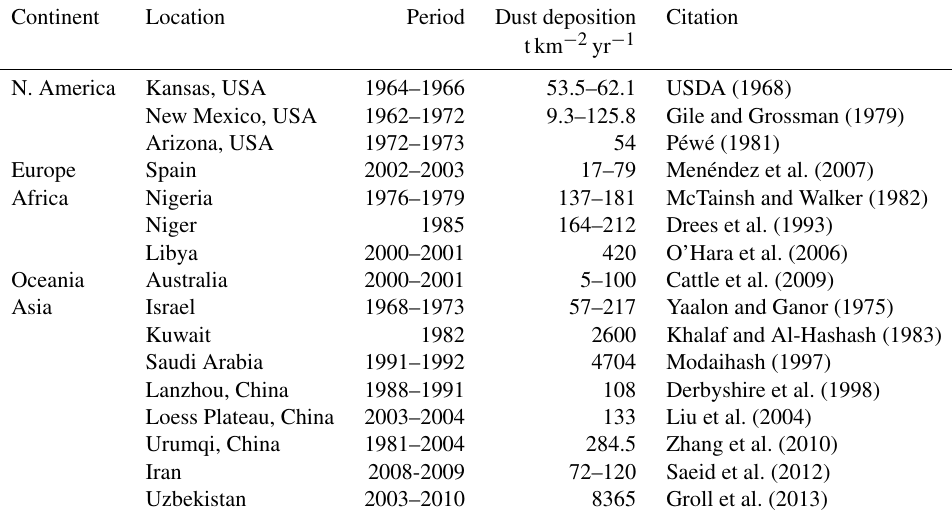
Table 1. Observations of dust deposition in desertification regions.